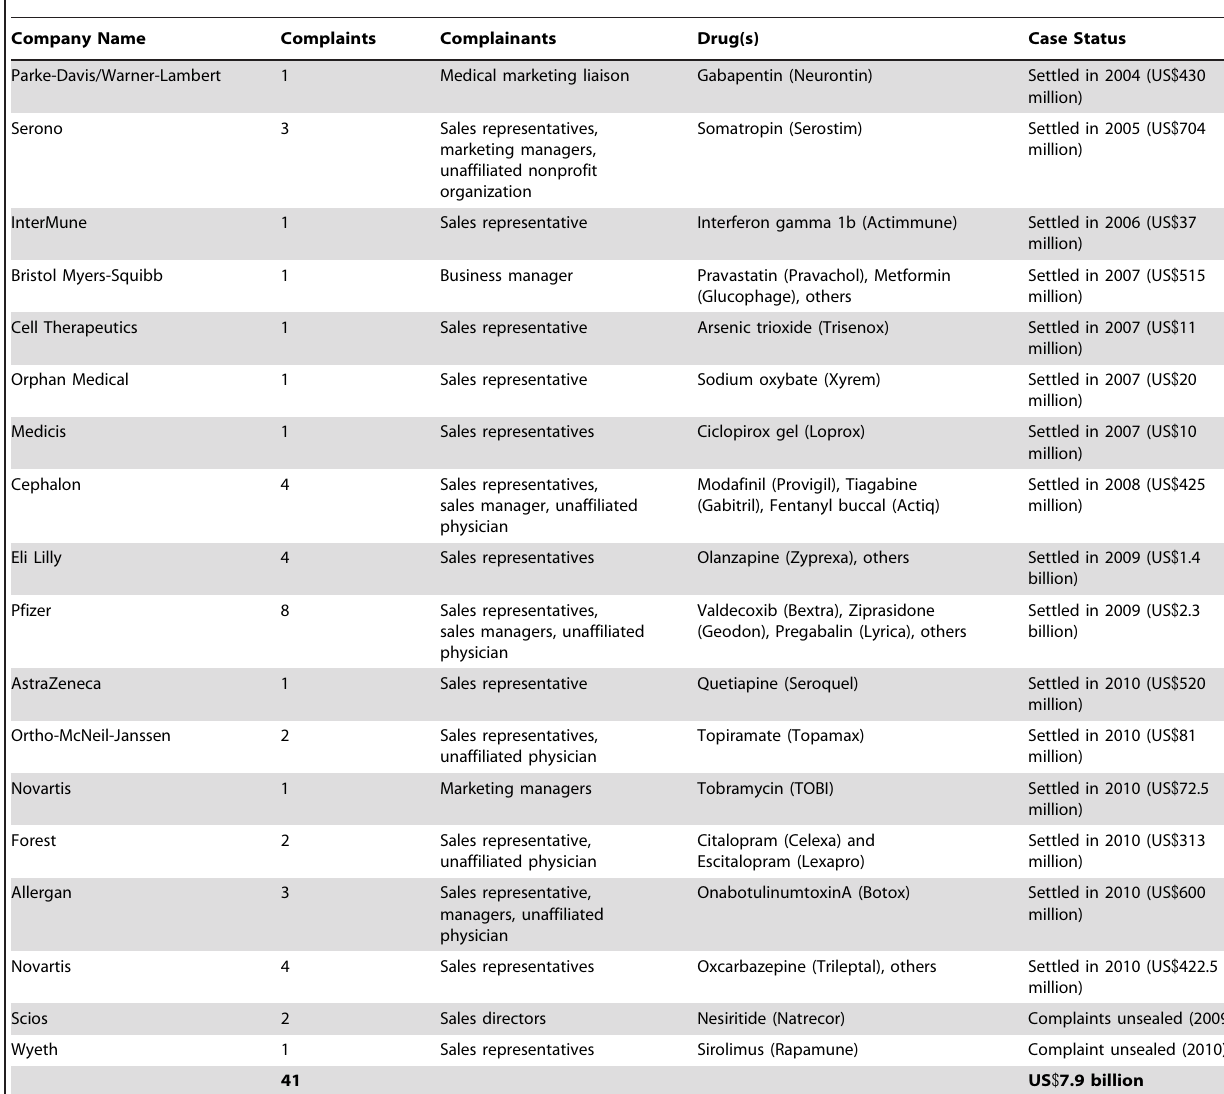
Table 1. Pharmaceutical fraud cases related to off-label marketing, January 1996–October